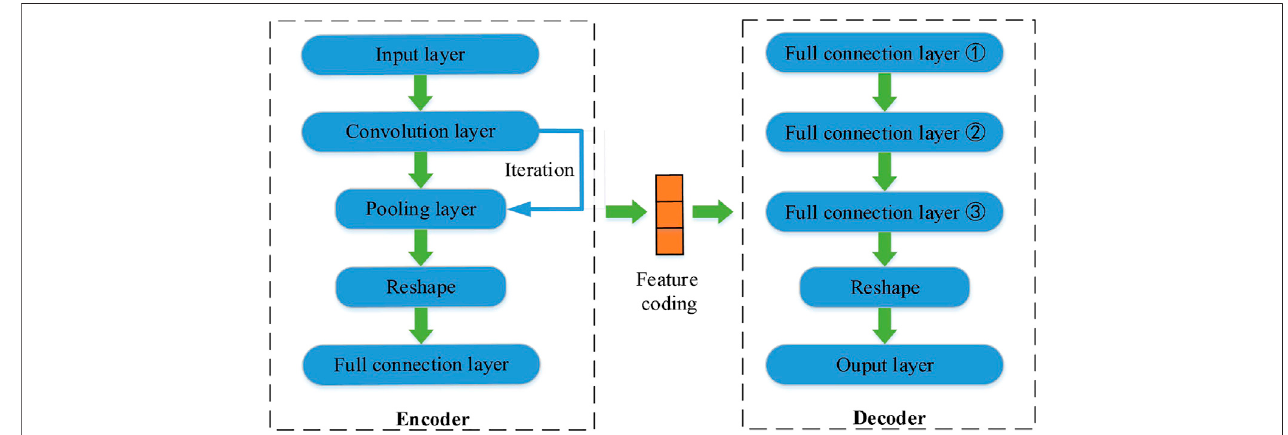
FIGURE 2 | Structure of the 1D-CAE